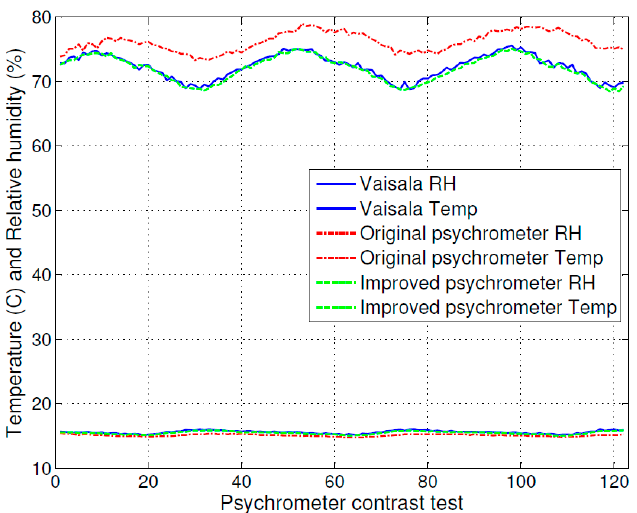
Figure 6. Comparison of temperature and relative humidity using the original psychrometer, the improved psychrometer, and the relative humidity measurement instrument (HMP75).